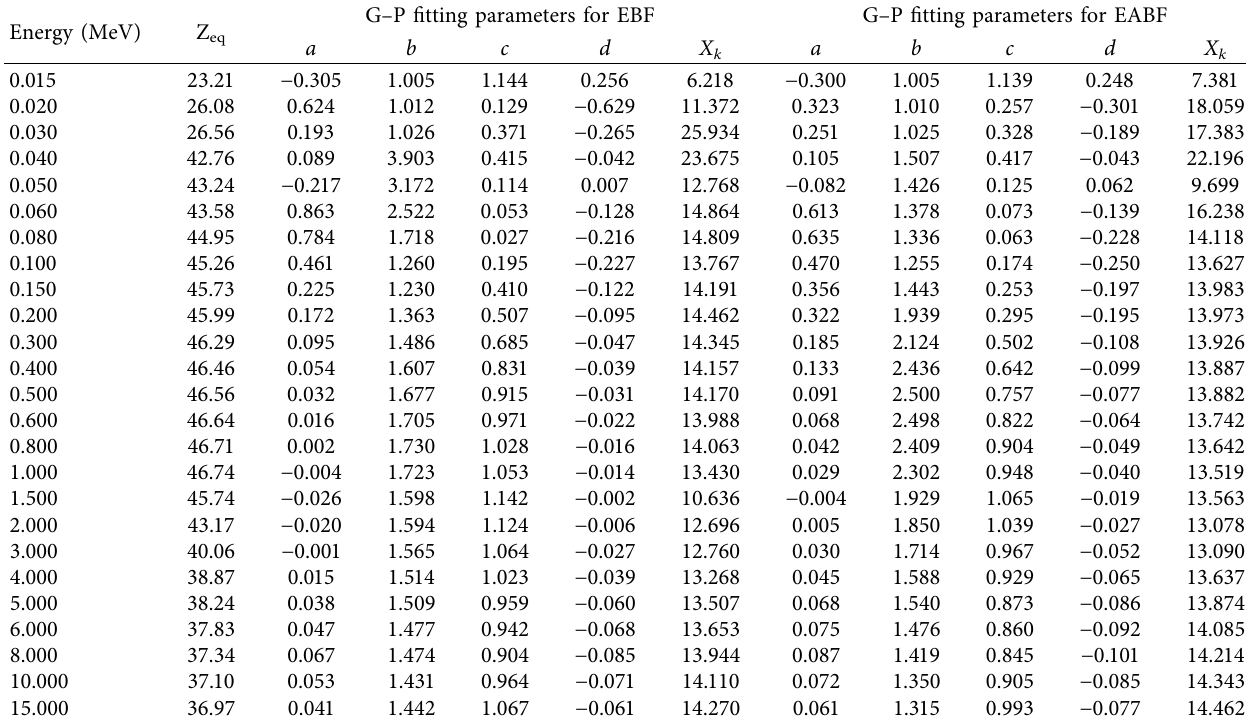
k , and d ) of the S2